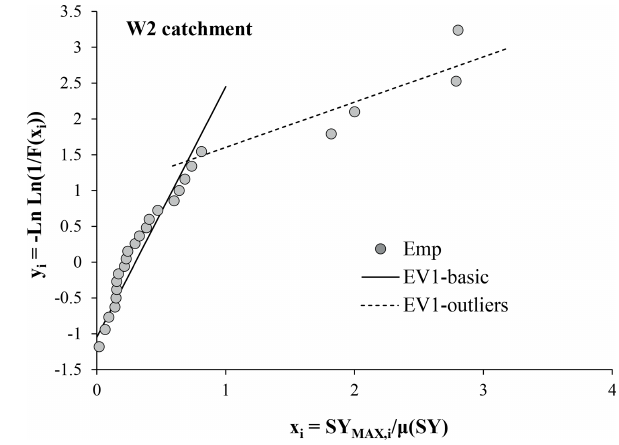
Figure 1. Gumbel’s plot for the dataset of the normalized variable, x i = SY MAX ,i /µ